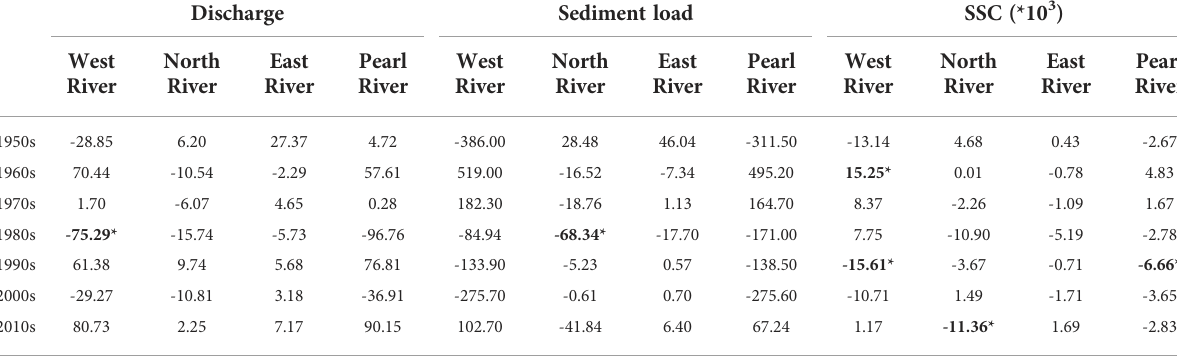
The data in bold with * indicates statistically signi fi cant (P<